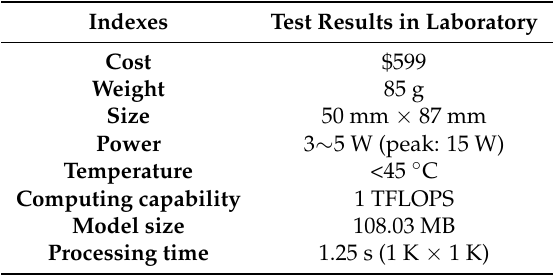
Table 5. The indexes of Jetson TX2 tested in